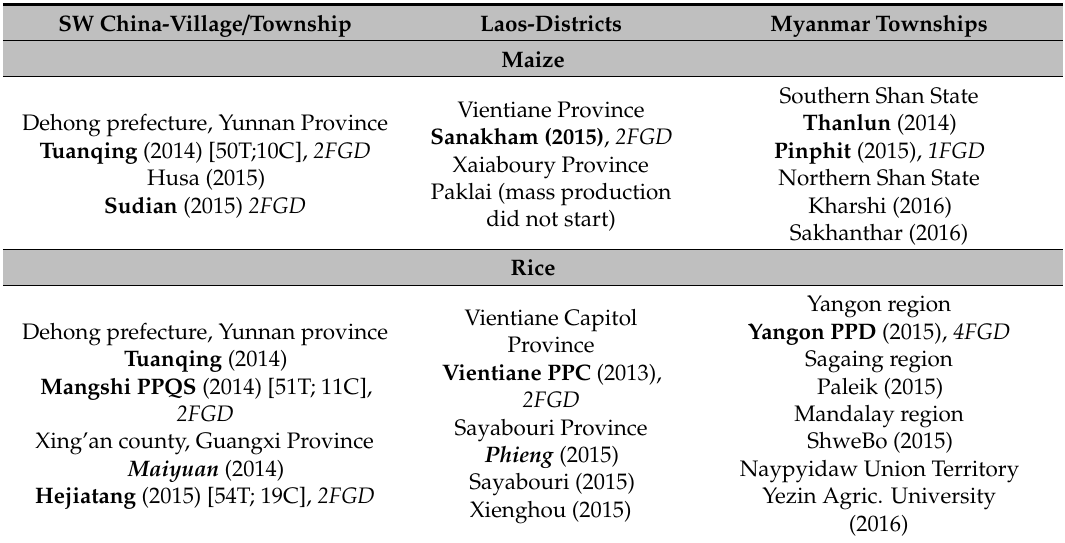
Table 1. Locations where Trichogramma rearing facilities (TRF) were established (the year when mass Trichogramma rearing started); number of treatment (T) and control (C) farmers in household questionnaire surveys (HHS) in Southwestern China, and number of focus group discussions (FGD). On-site visits to implement KIIs were carried out in locations in bold or with individuals from locations in bold italics travelling to a central